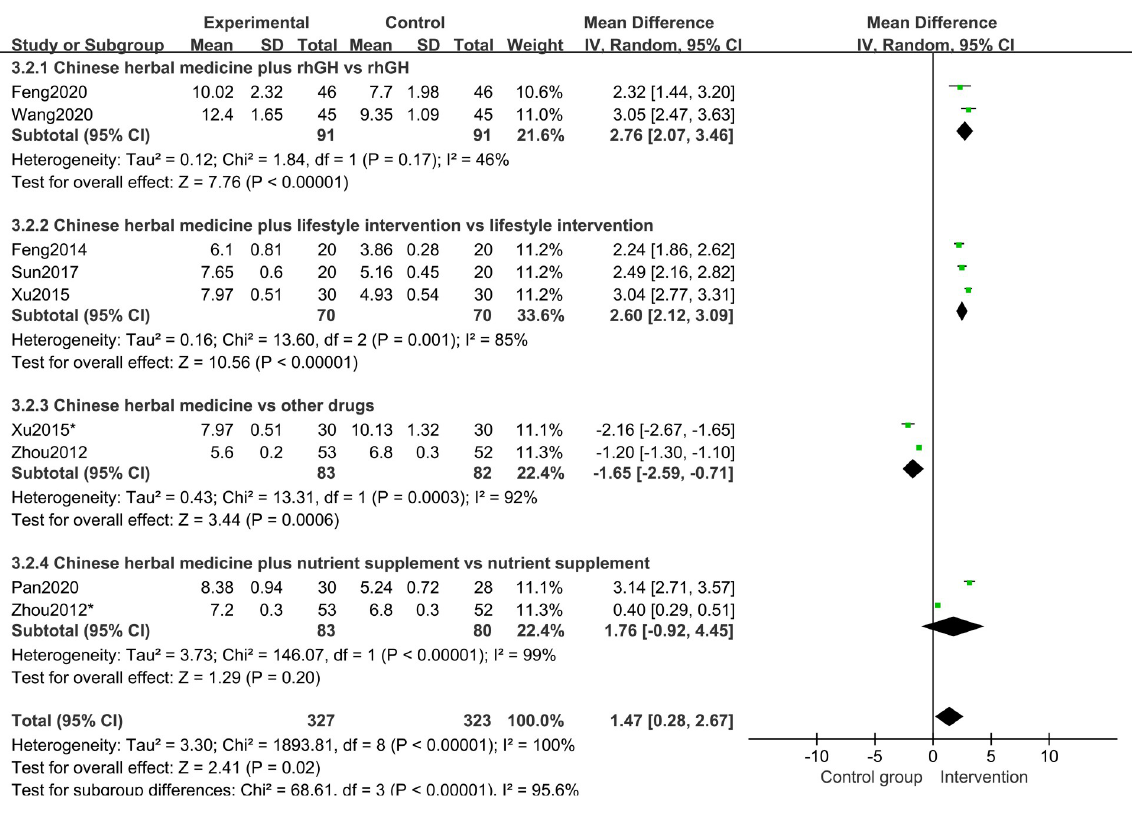
Fig 8. Subgroup analysis of growth velocity based on the interventions.